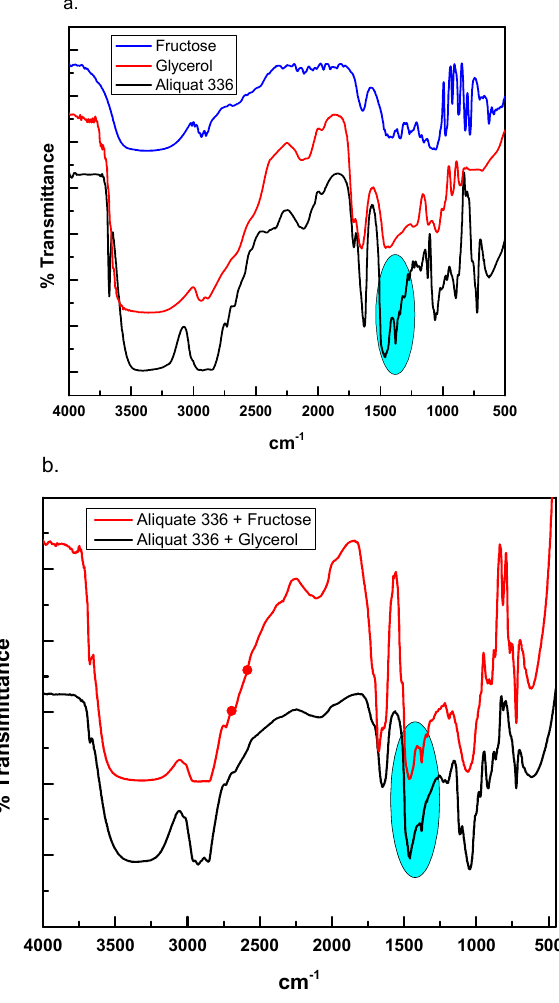
Figure 1 . FTIR spectra for Aliquat 336, glycerol and fructose, and their synthesized DES (DES-4 and DES-11) before and after formation. ( a ) represents the FTIR spectra of individual components whereas ( b ) represents the FTIR spectra of two separate synthesized DESs.